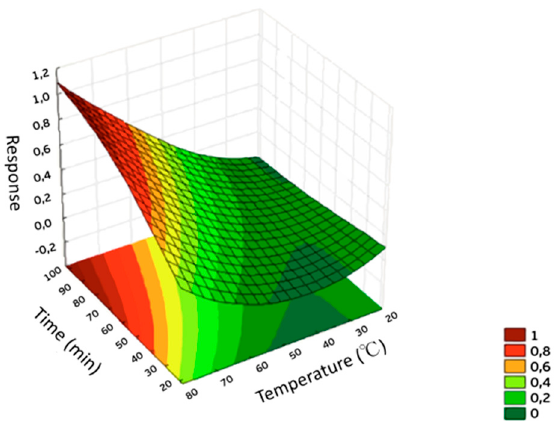
Figure 3. Response surface obtained for the optimization of DI-SPME procedure using biosorbent fiber (diatomaceous earth).